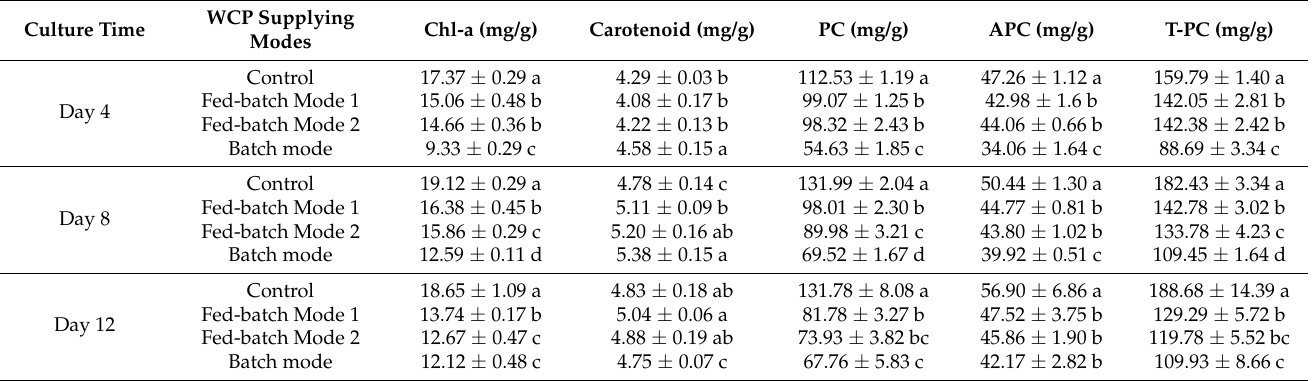
Table 3. Photosynthesis pigments content of Arthrospira platensis as affected by caprolactam wastewa- ter supply modes. Data with different letters indicate significant differences ( p < 0.05) between the control and treatments.